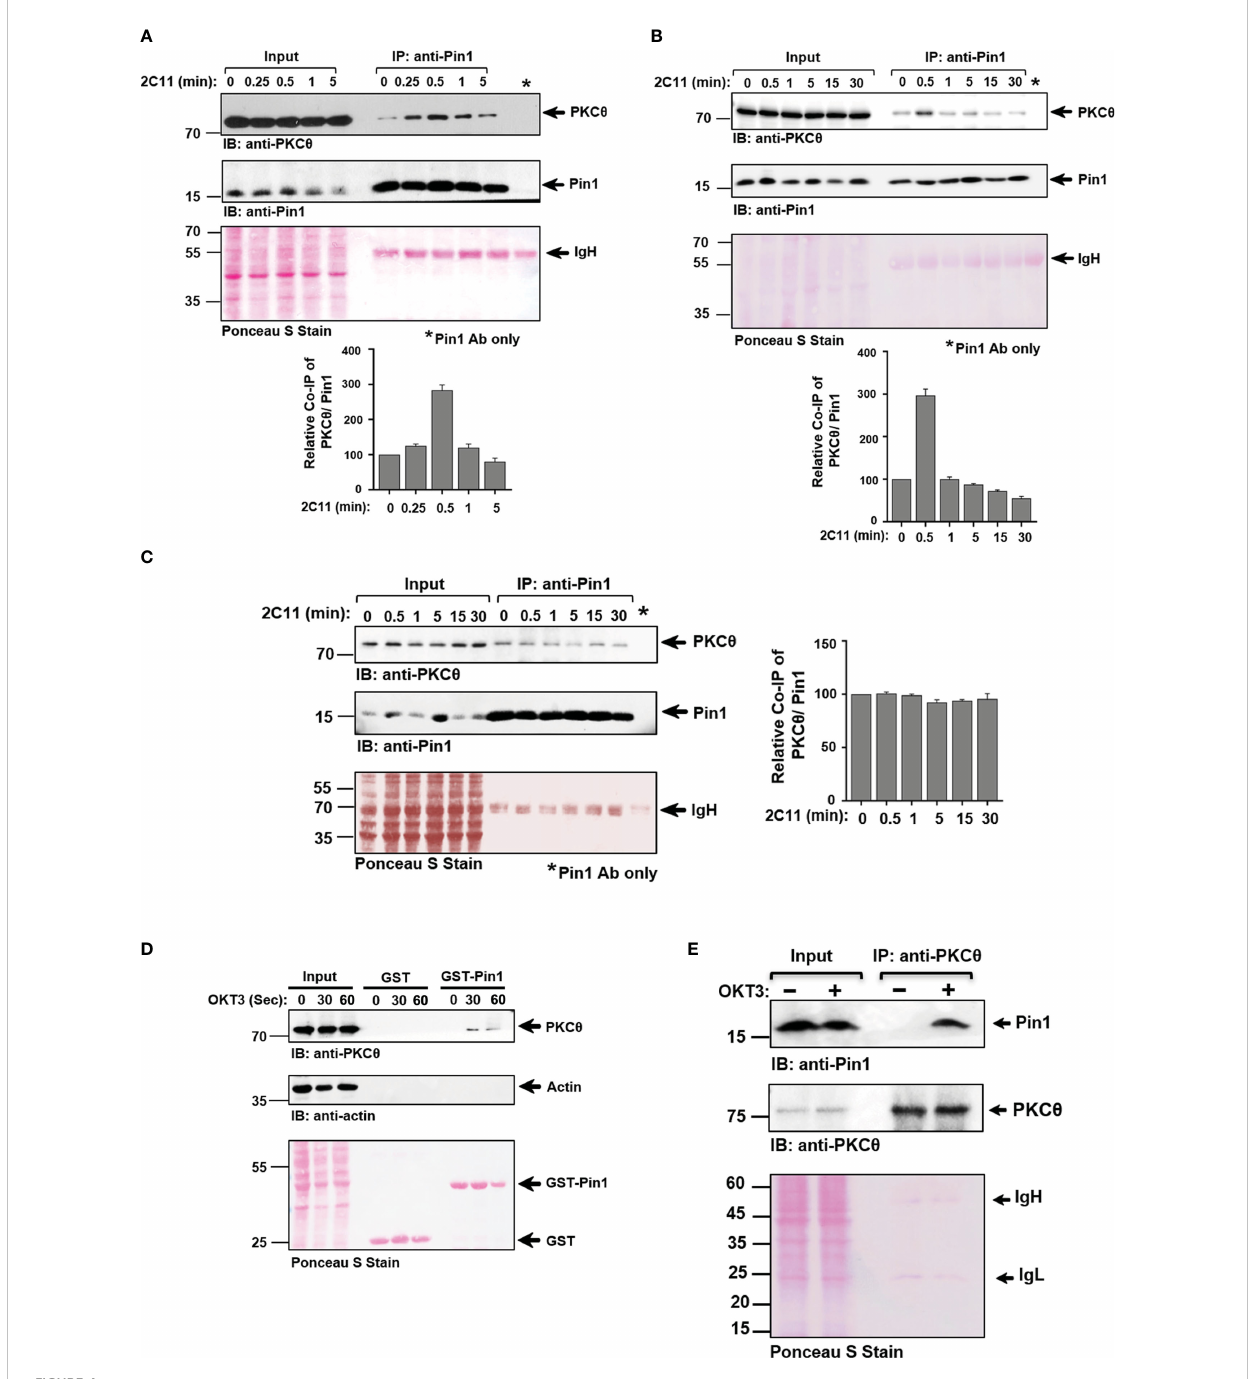
FIGURE 4 Pin1 association with PKC q in C57BL/6J-derived T cells is inducible and cell activation-dependent in splenic T cells, in contrast to the constitutive association in thymic T cells. A-B. Splenic T cells derived from C57BL/6J mice were activated for the indicated time points [0-5 min (A) ], or [0- 30 min (B) ] using anti-CD3 ϵ mAbs (2C11). Whole-cell lysates (Input) and Pin1 immunoprecipitates (IP) were subjected to immunoblotting (IB), as indicated, and quanti fi cation of the protein band signal intensities was performed using Image J software. (C) Thymic T cells derived from C57BL/6J mice were activated for the indicated time points (0-30 min) using anti-CD3 ϵ mAb (2C11). Whole-cell lysates (Input) and Pin1 immunoprecipitates (IP) were subjected to immunoblotting (IB), as indicated, and the protein band signal intensities was performed using Image J software. (D) Jurkat TAg cells were stimulated with anti-CD3 mAb (OKT3) at the indicated time intervals and cell lysates were subjected to a pull-down assay using GST and GST-Pin1 fusion proteins followed by immunoblotting (IB), as indicated. (E) OKT3-stimulated Jurkat T cells were subjected to immunoprecipitation using anti-PKC q mAbs, followed by SDS-PAGE of WCL (Input) and PKC q immunoprecipitates and sequential immunoblotting with anti-Pin1 and anti-PKC q mAbs. Membrane staining with Ponceau S monitored the equal loading of proteins in all lanes. Data are representative of three independent experiments. Molecular weight markers (in kDa) are indicated on the left and arrow mark positions of the indicated protein bands. IgH, Ig heavy